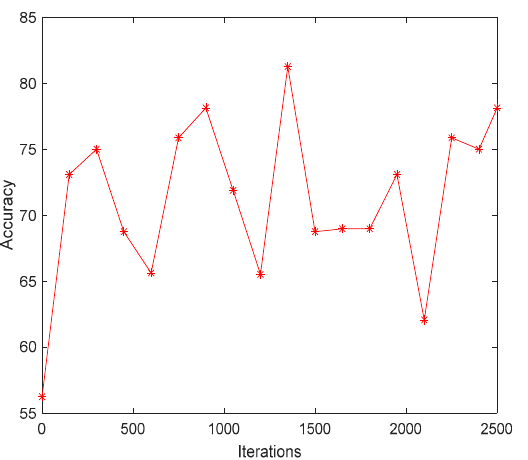
Figure 7. Result of predicting object accuracy of the proposed algorithm (GC-MRCNN). In 2014, the first version of the COCO dataset was released. It has 164 K photos divided into three sets: Training (83 K), validation (41 K), and test (41 K). A fresh test set of 81 K photographs was released in 2015, which included all the previous test images as well as 40 K new